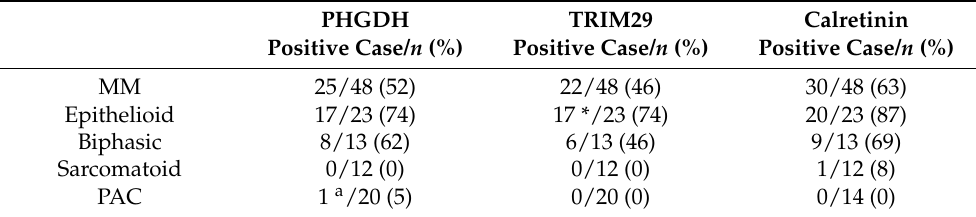
Table 3. Immunohistochemical expression in MMs and PACs.